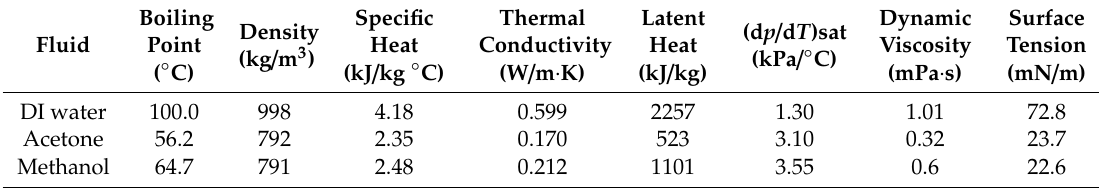
Table 2. Physical properties of working fluids at 1 atm.